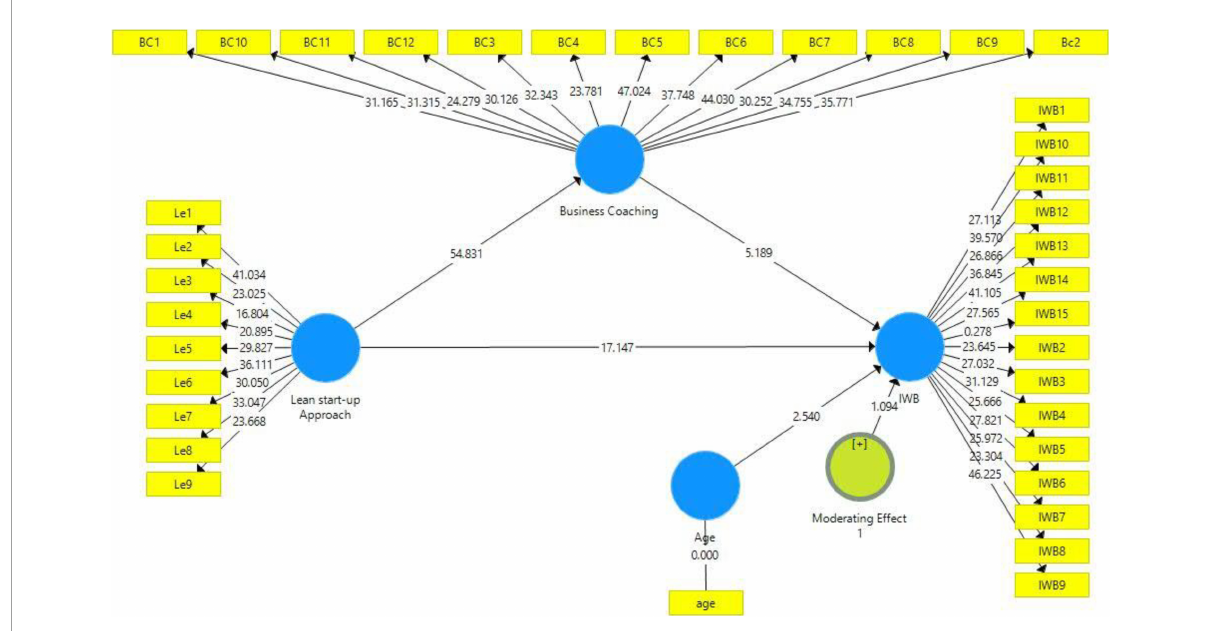
FIGURE3 Structural equation